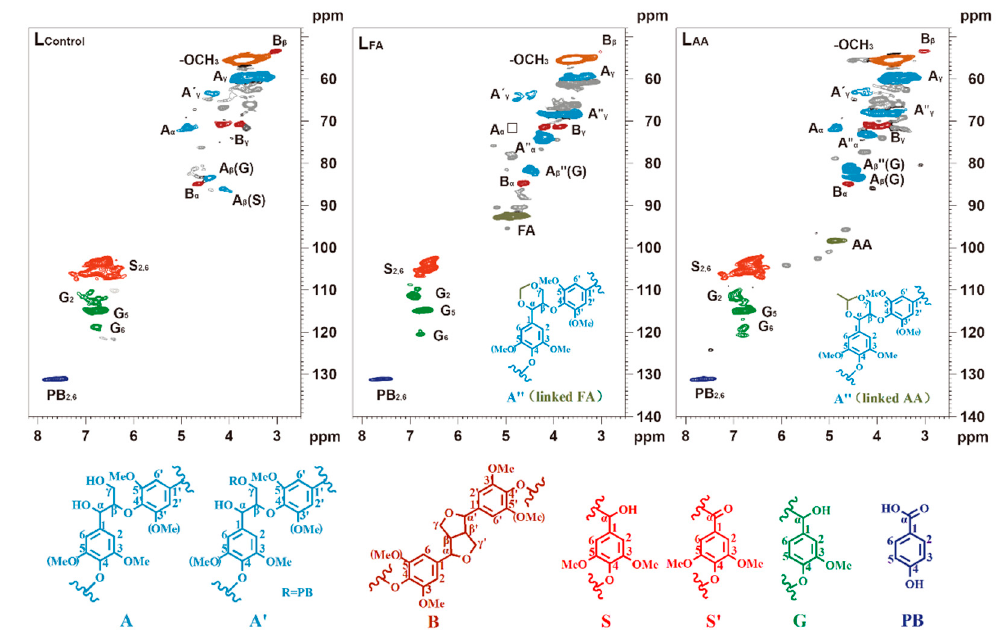
Figure 1. 2D-HSQC spectra of the lignin obtained from 40–60 meshed poplar wood and the main substructures. L Control represents the lignin extracted from an acid solvent without the addition of aldehyde; L FA represents the lignin extracted with the presence of FA; L AA represents the lignin extracted with the presence of AA.